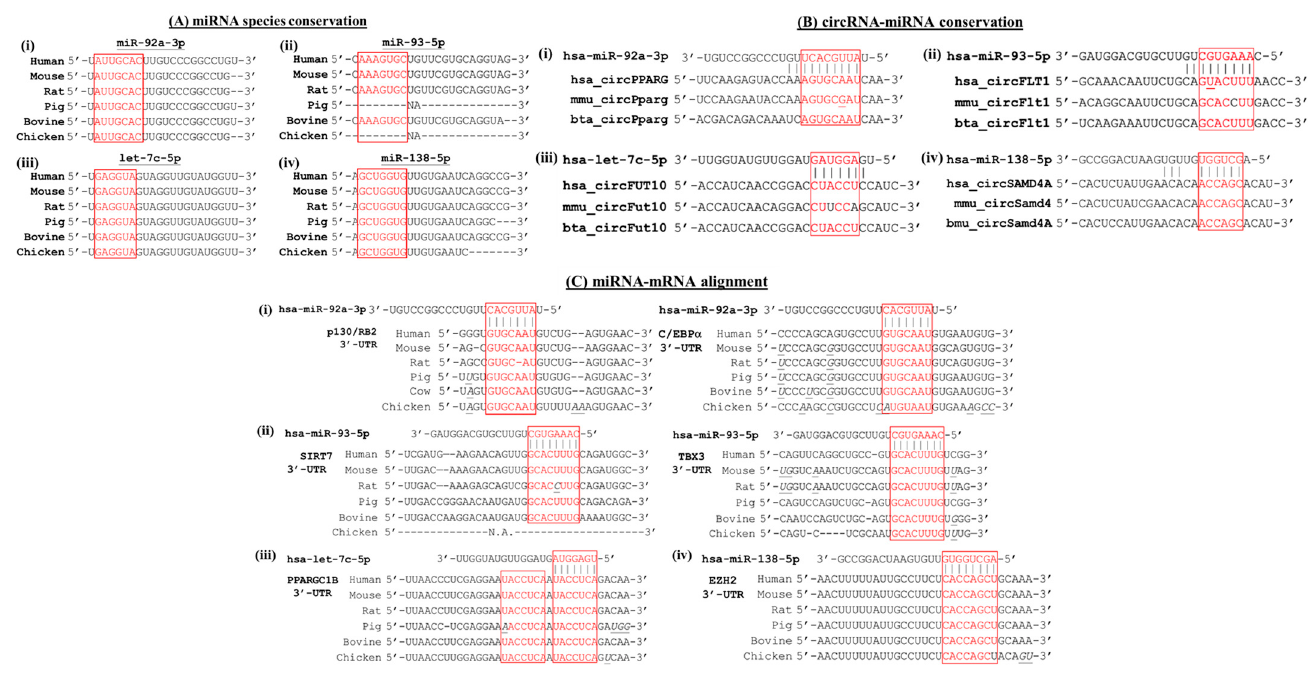
Figure 2. Cross-species alignment and conservation of the circRNA–miRNA and miRNA–mRNA interacting sequences in adipogenesis differentiation. ( A ) miRNA conservation among different species. ( B ) circRNA–miRNA interactions. ( C ) miRNA–mRNA interactions. circRNA sequences are derived from circBase (http://www.circbase.org) and circBank (http://www.circbank.cn); miRNA sequences are derived from miRbase; 3 ′ -UTR of mRNA is derived from TargetScan (https://www.targetscan.org). Seed sequences are shown in the red box; homologous seed nucleotides are shown in red letters and mismatches are shown in black letters in the seed sequence box. “-” indicates a gap in the sequence. In the circRNA–miRNA alignments in ( B ), G–U wobbles are underlined. NA, not available in databases.